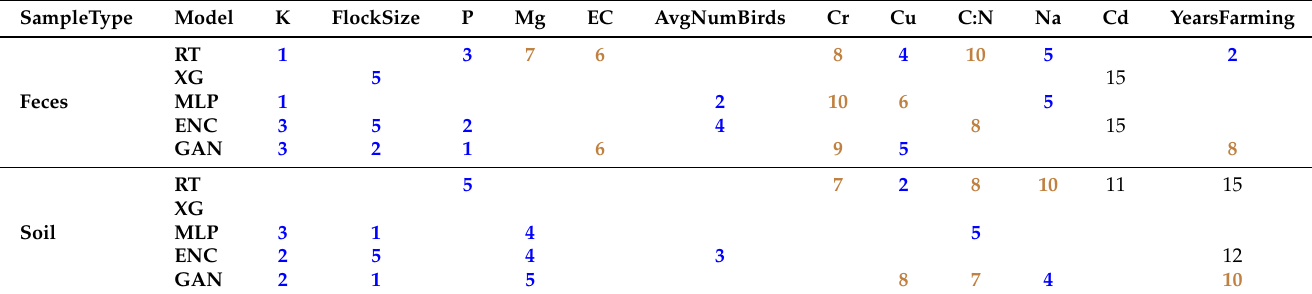
Table 5. The influential variables and their rank in their respective algorithm for the prediction of Listeria multidrug resistance (L_MDR). Please see Table A1 for variable descriptions. The top five ranks are shown in blue and the top ten in brown . Overall, top five most influential variables for L_MDR in feces are K, P, FlockSize, Cu, and Cr, while the top five for soil are K, FlockSize, Mg, C:N, and YearsFarming.